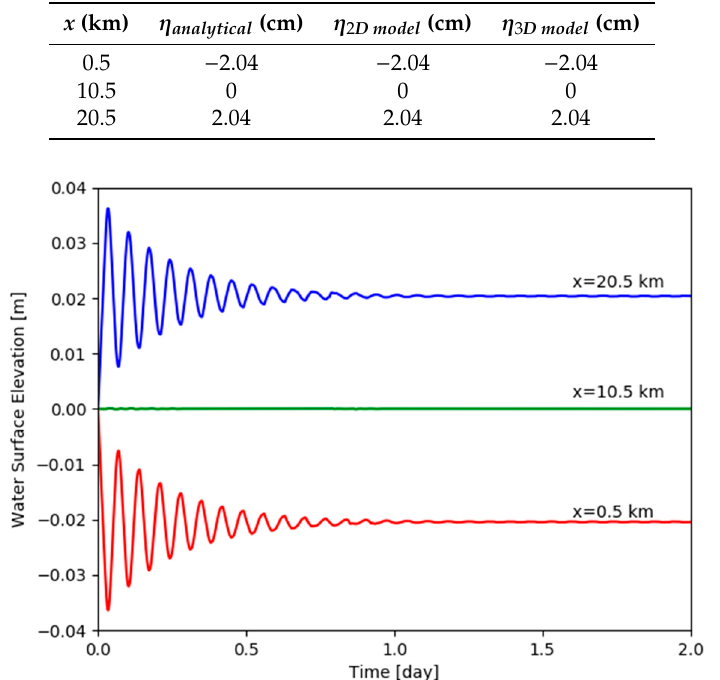
Table 1. Comparisons between analytical and simulated wind setup, where 𝜂 is the setup of the water surface.